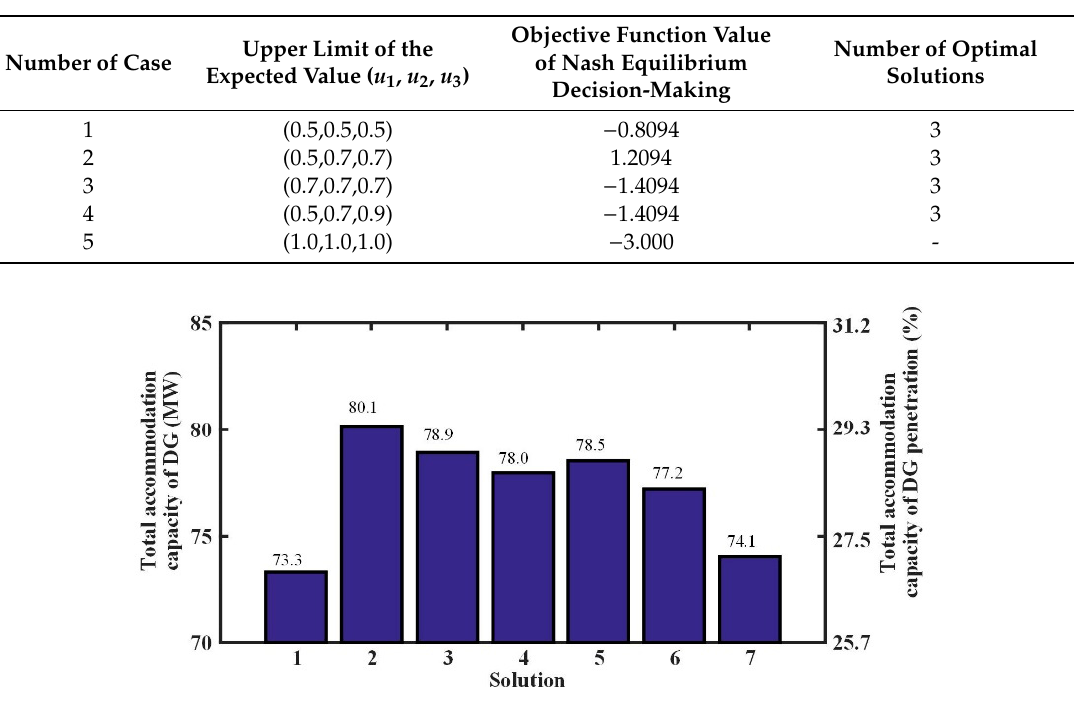
Figure 7. The DG accommodation capacity of each node under two scenes.